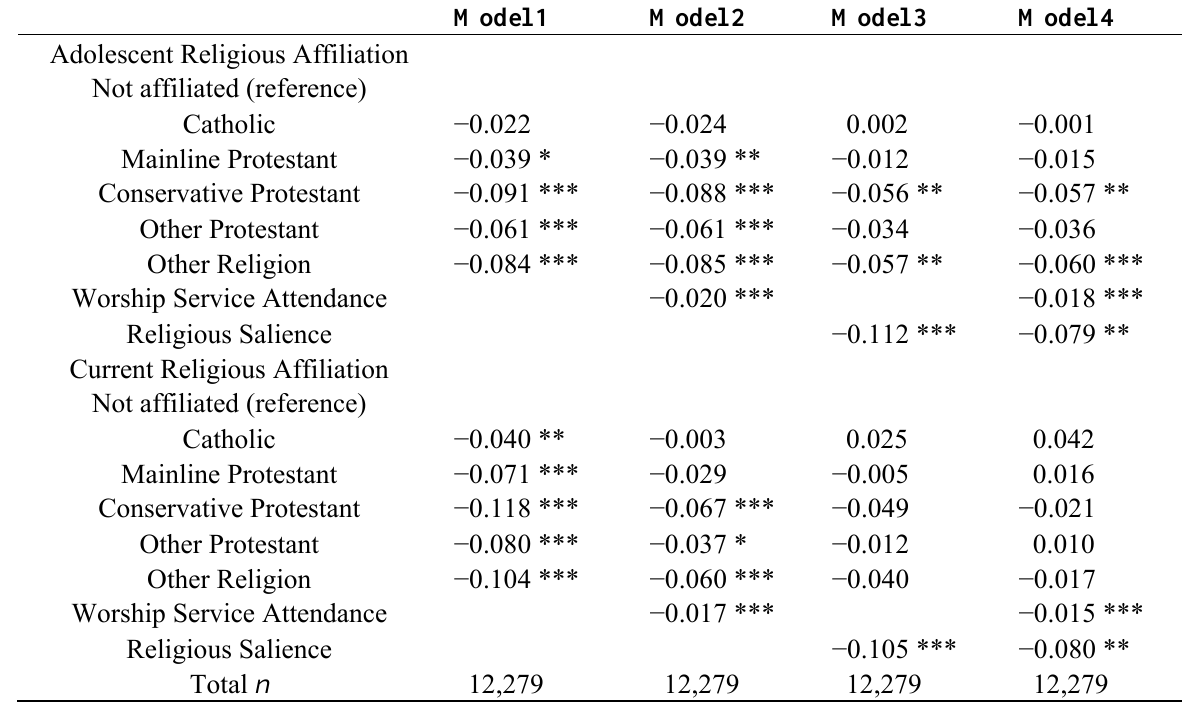
Table 2. Maximum Likelihood Parameter Estimates from Log-Logistic Survival (AFT) Regressions of Waiting Time on Religious Variables for Women.